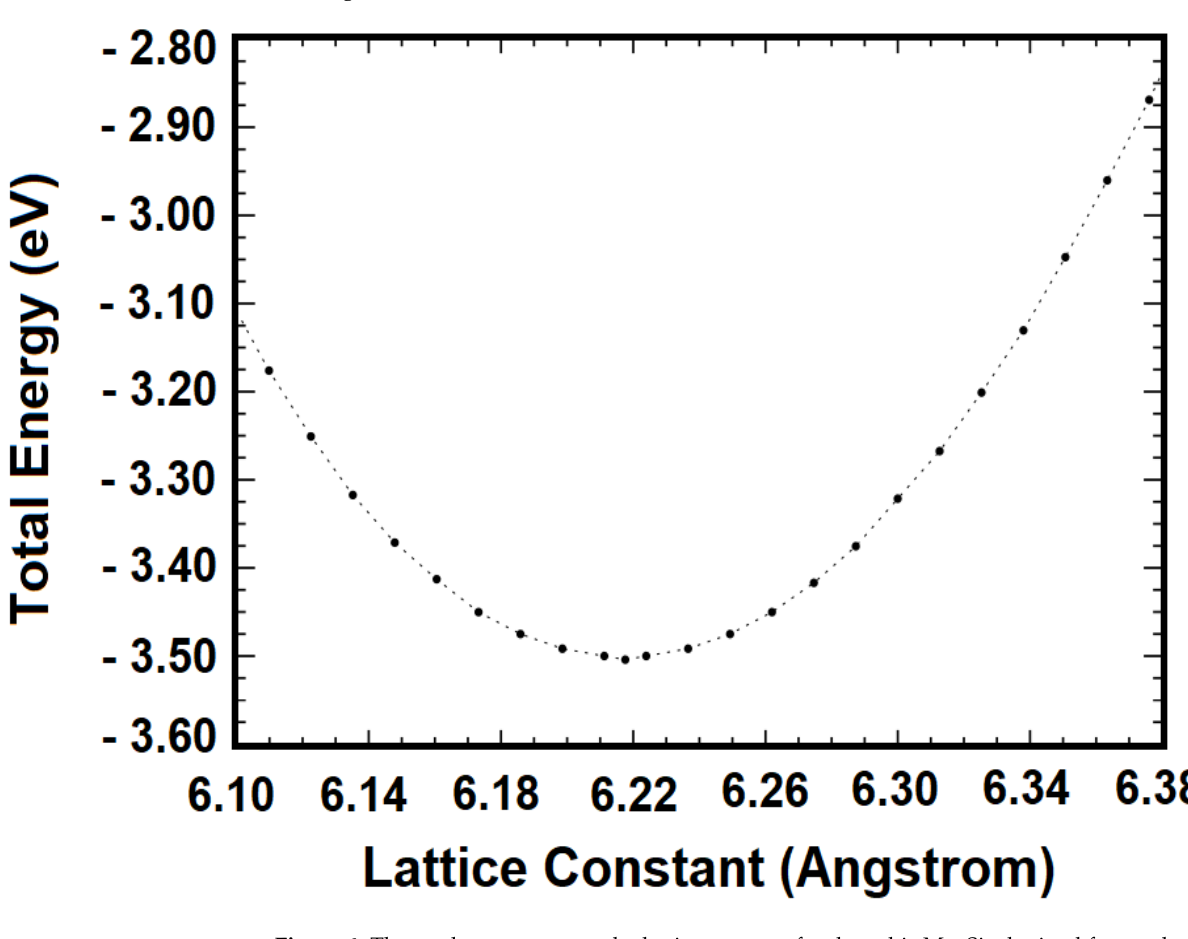
Figure 6. The total energy versus the lattice constant for the cubic Mg 2 Si, obtained from calculations employing the optimal basis set at various lattice constants.